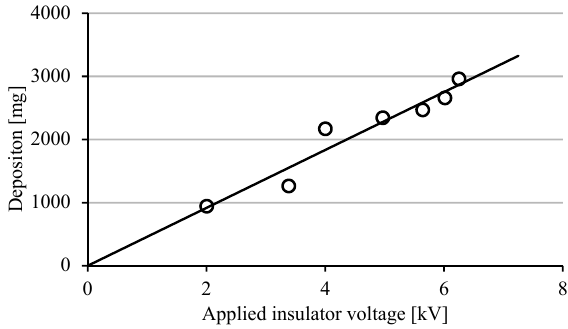
Figure 10. The relationship between deposition and applied insulator voltage [33].